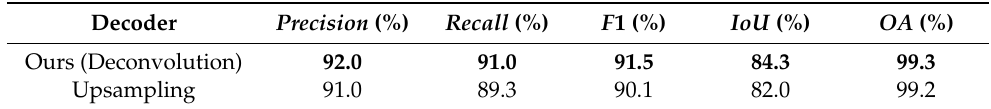
Table 5. Quantitative evaluation of networks with different settings in the decoder used on the WHUCD dataset. The highest numbers are in bold.